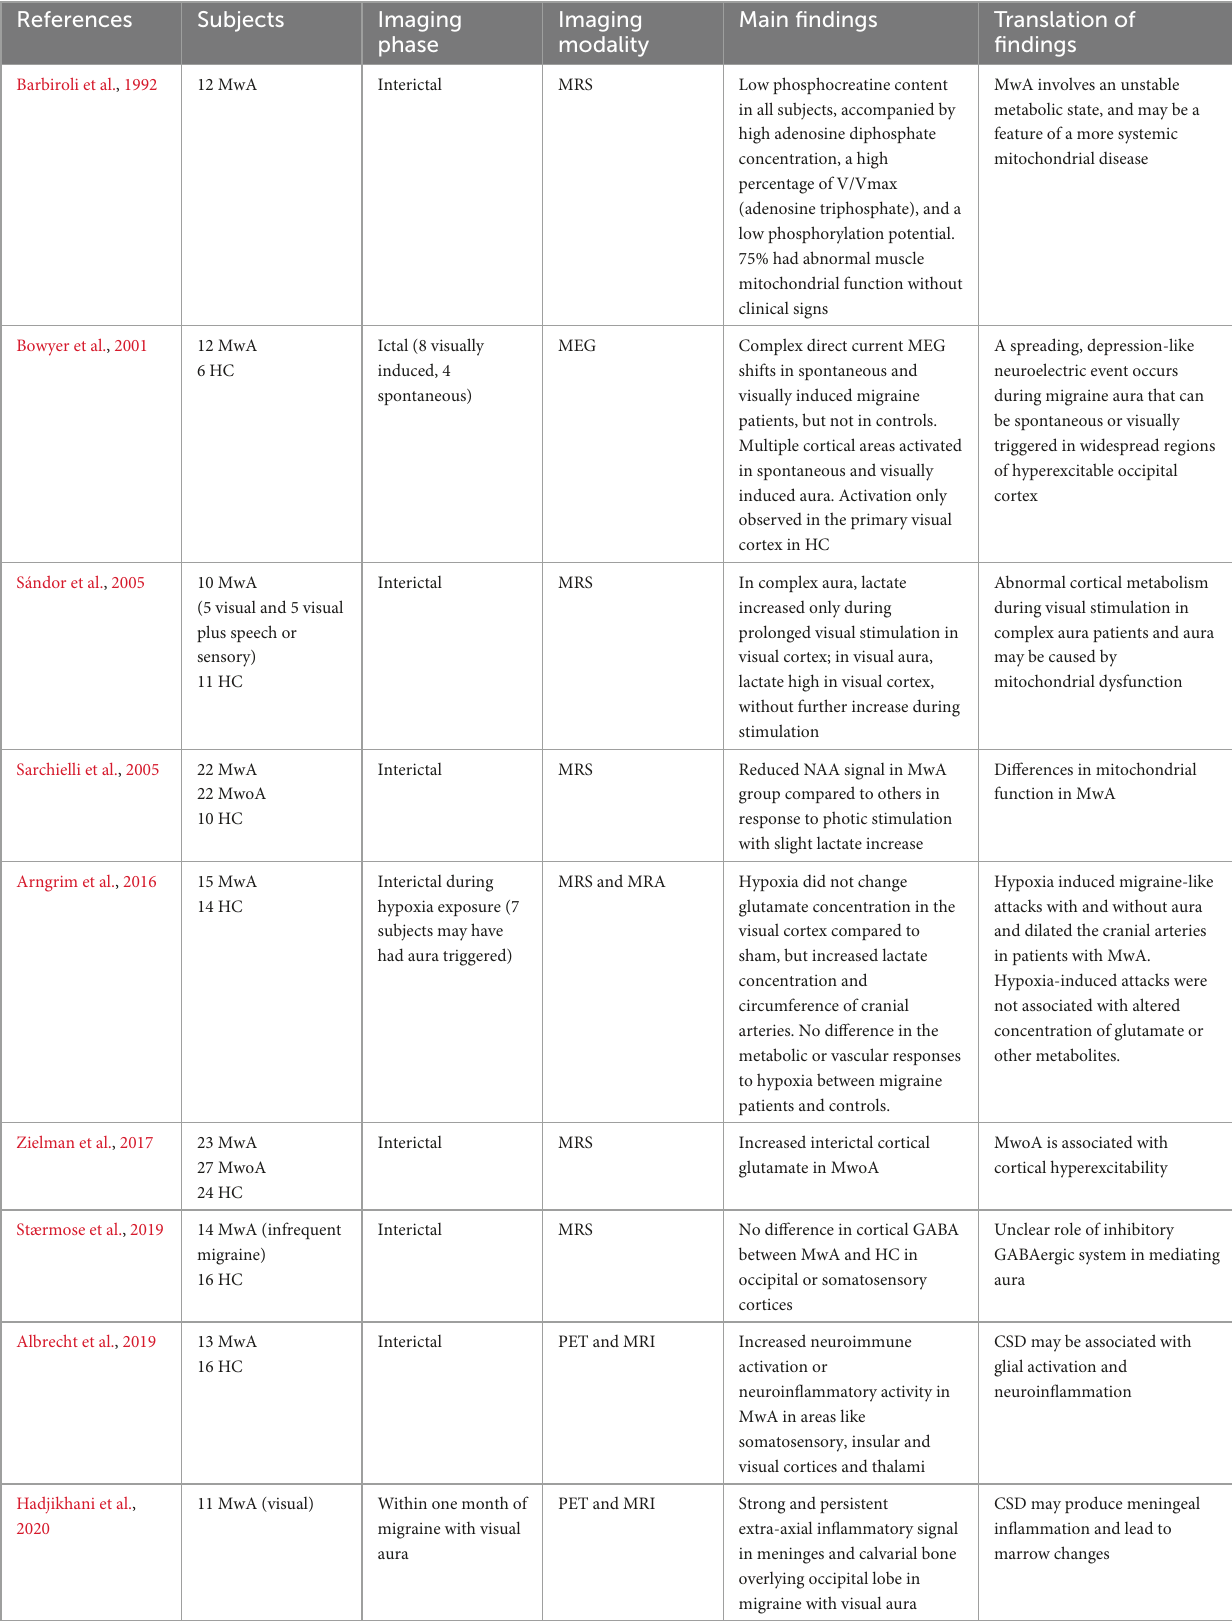
TABLE 4 A summary of studies using other advanced imaging techniques in migraine with typical